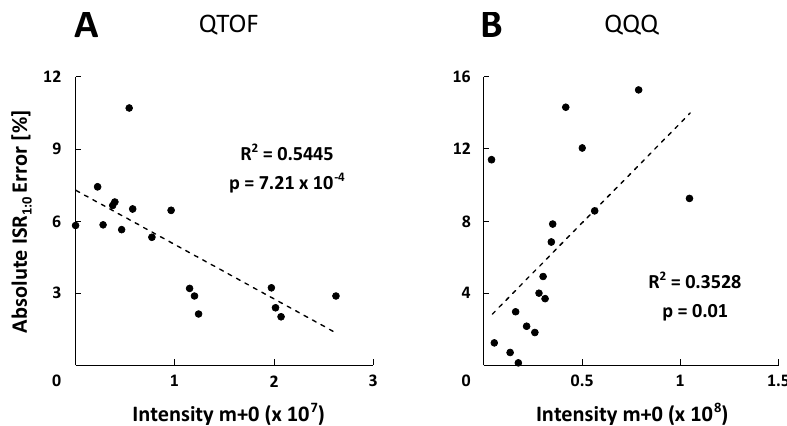
Figure 4. Correlation between absolute ISR 1:0 error values and intensities of the monoisotopic ion ( m+0 ). Each data point corresponds to one metabolite of a non-labeled reference standard mix. Linear regression coefficients ( R 2 ) and p-values are depicted for the QTOF-HRMS ( A ) and QQQ-SIM detection ( B ).